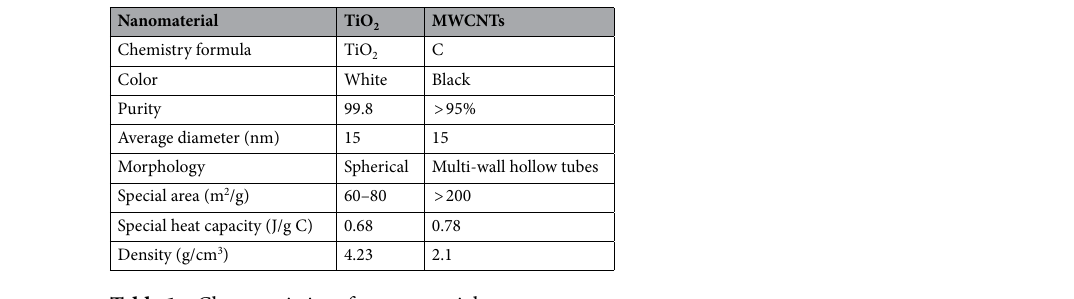
Table 1. Characteristics of